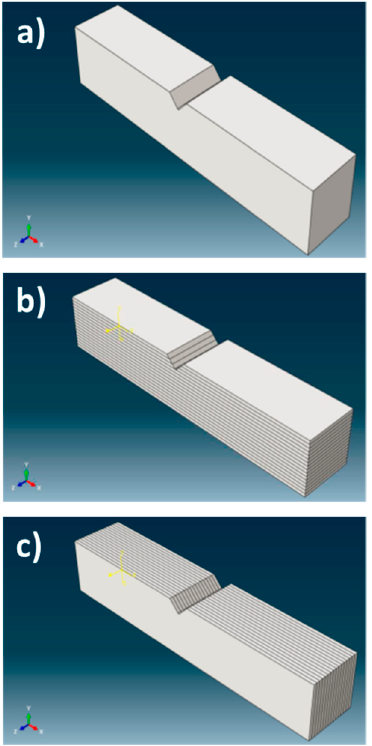
Figure 7. ( a ) Single crystal configuration; ( b ) arrester configuration; and ( c ) divider configuration. Table 4. Twist implemented at each partition for the “crack arrester” and “crack divider” configurations. Partition # Twist (°) 1 − 11 2 1 3 − 7